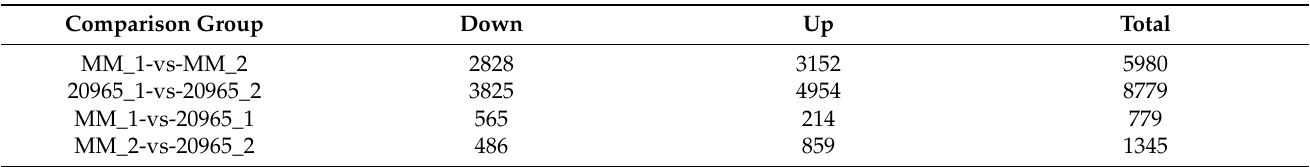
Table 2. DEGs identified from different comparisons.